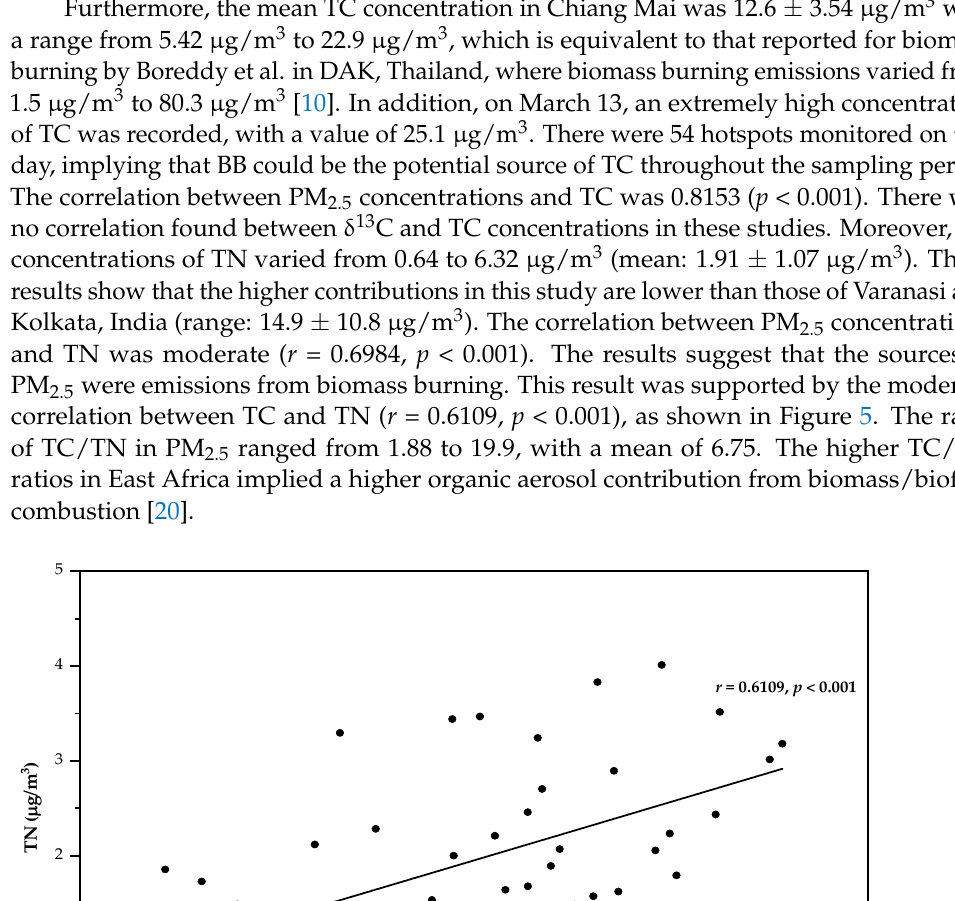
Figure 4. Relationship between stable isotopes and temperature in Chiang Mai city.